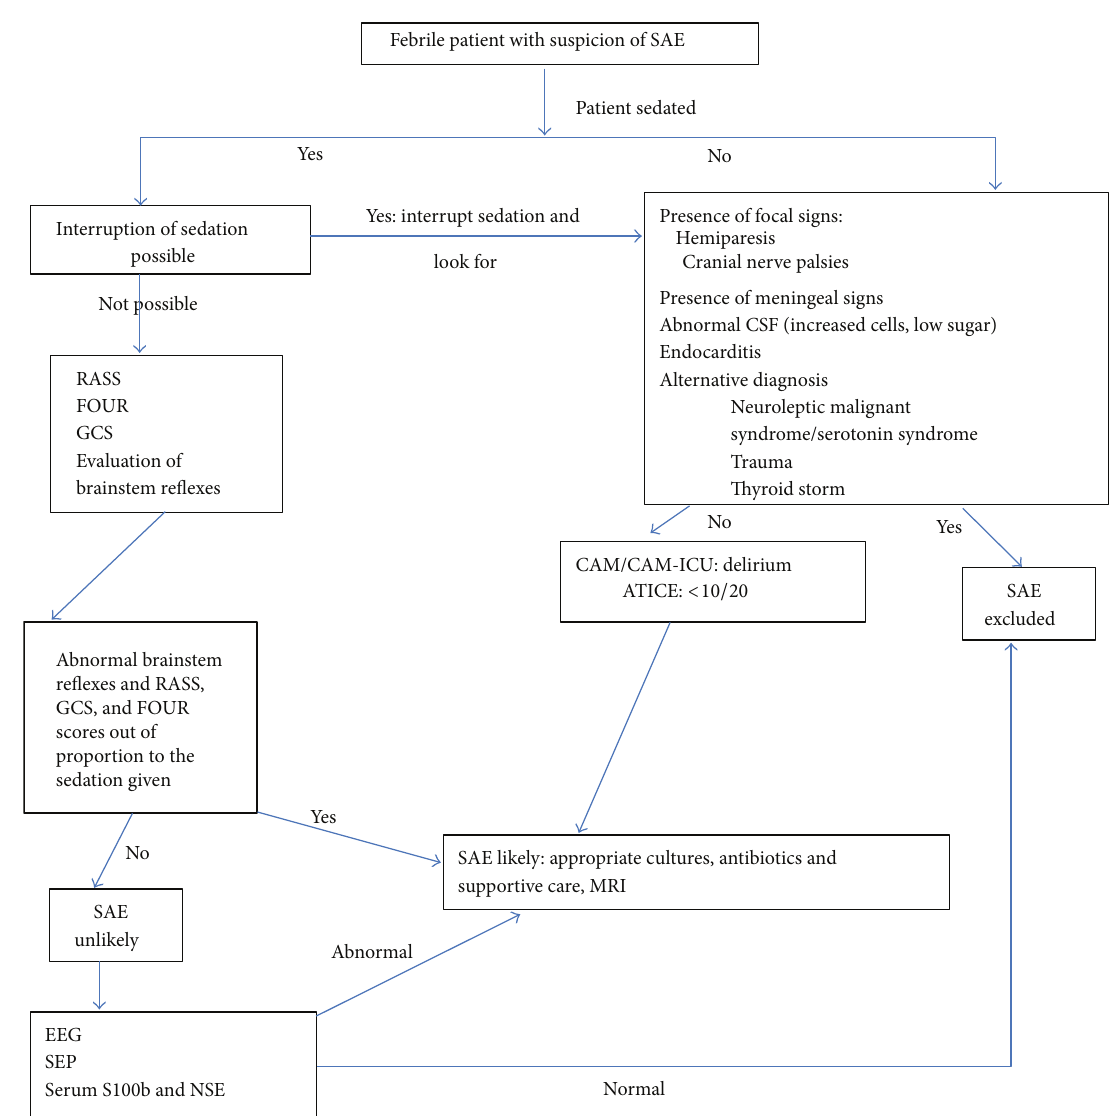
Figure 2: Algorithm for diagnosis of sepsis associated encephalopathy. RASS: Richmond Agitation-Sedation Scale, FOUR: Full Outline of Unresponsiveness, GCS: Glasgow coma scale, SEP: somatosensory evoked potentials, NSE: neuron specific enolase, CAM/CAM-ICU: Confusion Assessment Method (Intensive Care Unit), and ATICE: Assessment to Intensive Care